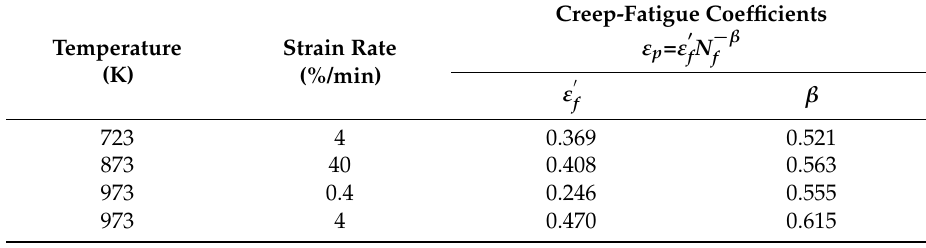
Figure 3. Prediction ratio for 63Sn37Pb solder.